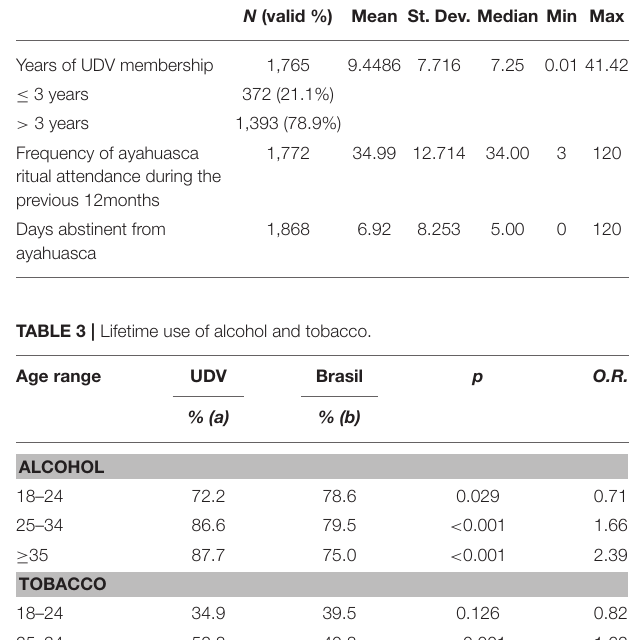
TABLE 4 | Current alcohol and tobacco use